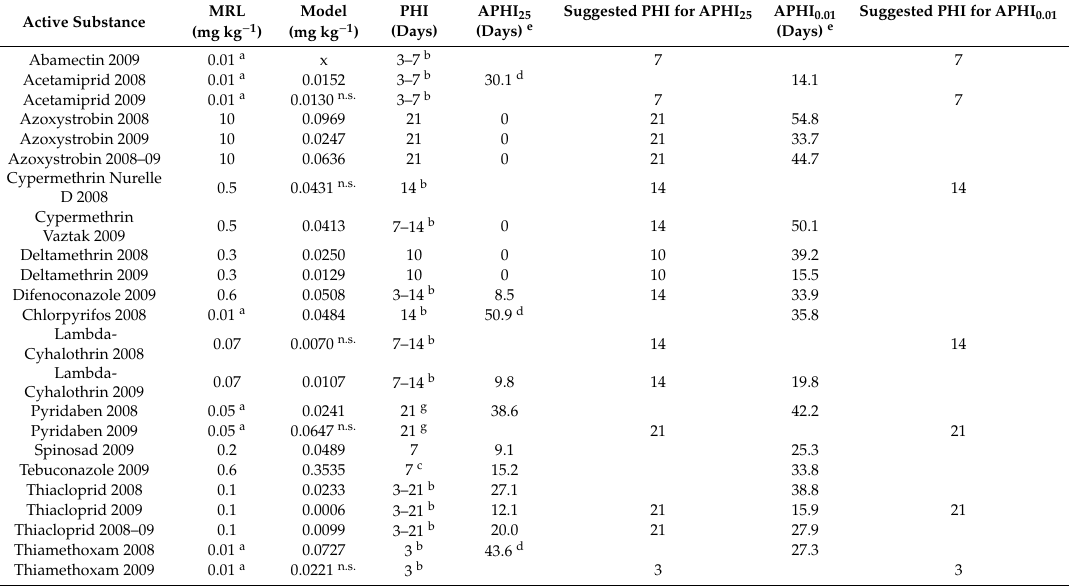
Table 4. Pesticide residues in